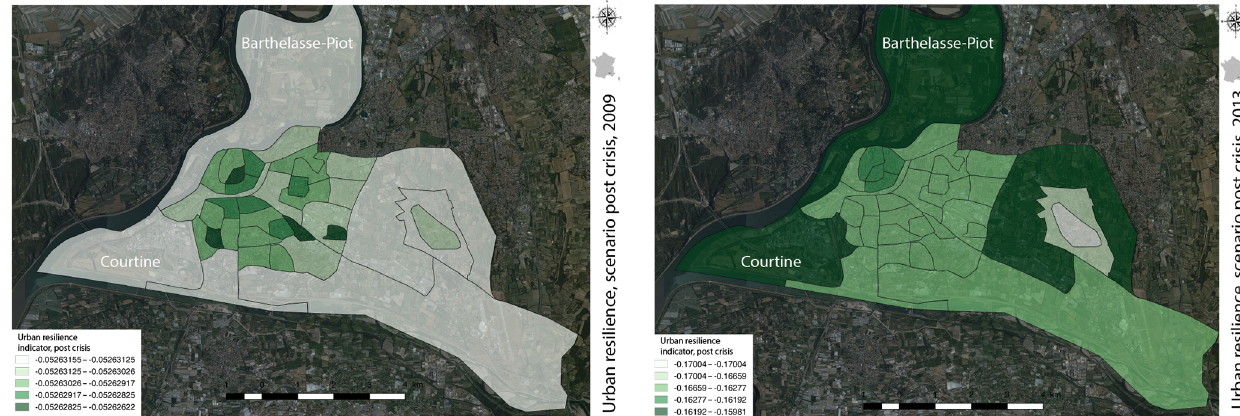
Figure 12. Comparative analysis between 2009 and 2013 for the urban indicator, post-crisis scenario, at the Avignon scale (IRIS-scale analysis). The map on the left identifies the most resilient areas according to the urban characteristics after a crisis in 2009; the map on the right identifies the most resilient areas according to the urban characteristics after a crisis in 2013 – © Open Database License, “ODbL” 1.0.